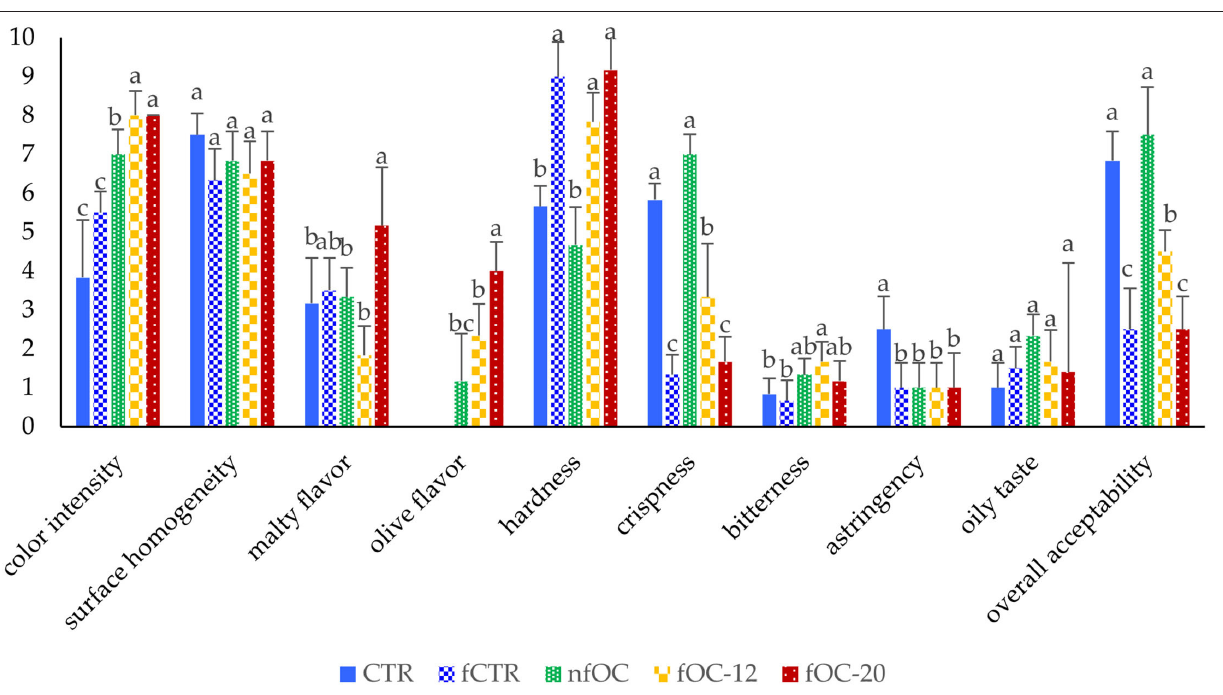
FIGURE 4 | Sensory evaluation of the gluten-free breadsticks. Different letters indicate significantly different ( p < 0.05) according to one-way ANOVA and Tukey’s HSD test. CTR, control breadsticks obtained by the dough without OC addition and without microbial fermentation; fCTR, breadsticks obtained by the dough without OC addition and fermented; nfOC, breadsticks obtained by the dough supplementation with 1% OC without microbial fermentation; fOC-12, breadsticks obtained by the dough supplementation with 1% OC and fermented for 12h; fOC-20, breadsticks obtained by the dough supplementation with 1% OC and fermented for